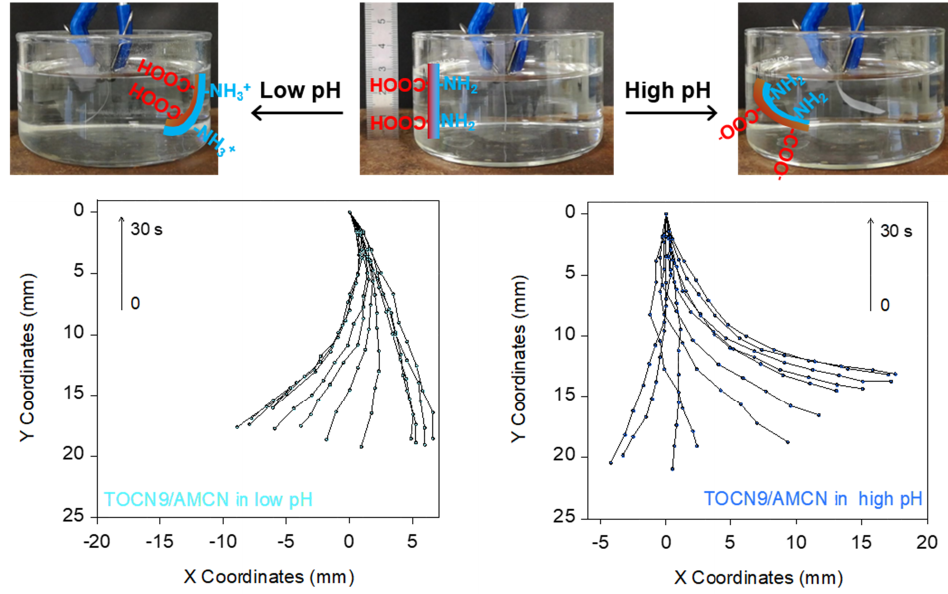
Figure 7. Photographs showing the change in bending of the TOCN9/AMCN films when they were immersed in low and high pH aqueous solutions (1 and 13, respectively); and X-Y plots showing the evolution of the curvature for times from 0 to 30 s.